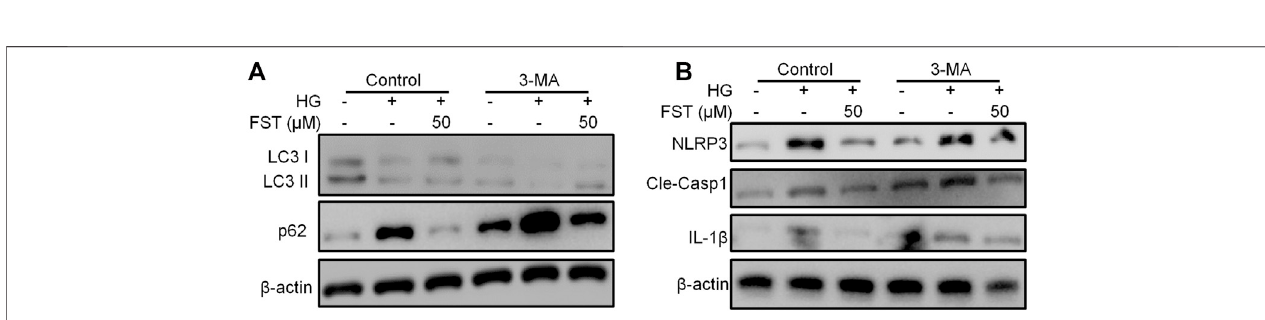
FIGURE 3 | Suppression of CDKN1B expression counteracted the effect of fi setin on podocytes cultured in high glucose concentrations. (A) Determination of the expression levels of CDKN1B in podocytes infected with lentiviruses expressing control shRNA and three CDKN1B shRNA for 48 h using qRT-PCR. (B,C) . Determination of the expression levels of CDKN1B in podocytes transfected with CDKN1B shRNA using qRT-PCR and western blot after treatment with fi setin and culturing in high glucose concentrations (30 mM) for 48 h. (D) Immuno fl uorescence staining of CDKN1B in podocytes transfected with CDKN1B shRNA after treatment with fi setin and culturing in high glucose concentrations (30 mM) for 48 h. Green indicates CDKN1B staining while blue indicates DAPI staining. (E) Quanti fi cation and analysis of apoptosis rates using fl ow cytometry in podocytes transfected with CDKN1B shRNA after treatment with fi setin and culturing in high glucoseconcentrations (30 mM) for 48 h. (F) Quanti fi cation and analysisof podocytes transfected with CDKN1B shRNA after treatment with fi setin and culturing inhigh glucose concentrations (30 mM) for 48 h using propidium iodide (PI) staining. Red indicates PI staining while blue indicates DAPI staining. (G,H) Determination of the expression levels of P-cadherin and ZO-1 in podocytes transfected with CDKN1B shRNA using qRT-PCR and western blot after treatment with fi setin and culturing in high glucose concentrations (30 mM) for 48 h. (I) Determination of the expression levels of phosphorylated P70S6K, P70S6K, LC3, p62, NLRP3, cleaved caspase-1, andIL-1 β inpodocytestransfectedwithCDKN1BshRNAusingwesternblotaftertreatmentwith fi setinandculturinginhighglucoseconcentrations(30 mM)for48 h. (J) The docking mode of FST in the binding site of CDKN1B (shown in ribbon representation and colored by structural elements). Data are expressed as means ± SEM ( n = 3).